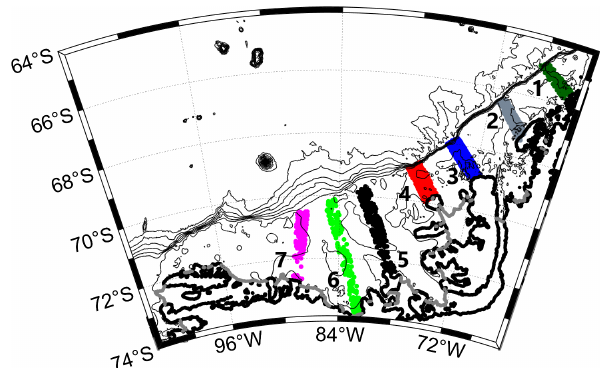
Figure 3. Distribution of profiles from instrumented seals used to construct composite, cross-shelf hydrographic sections. The tran- sects are numbered consecutively from 1, at the most northeast- ern end over the West Antarctic Peninsula shelf (see Appendix; Fig. A1), to 7, at the western edge of the Bellingshausen Sea. Con- tours are the same as in Fig.